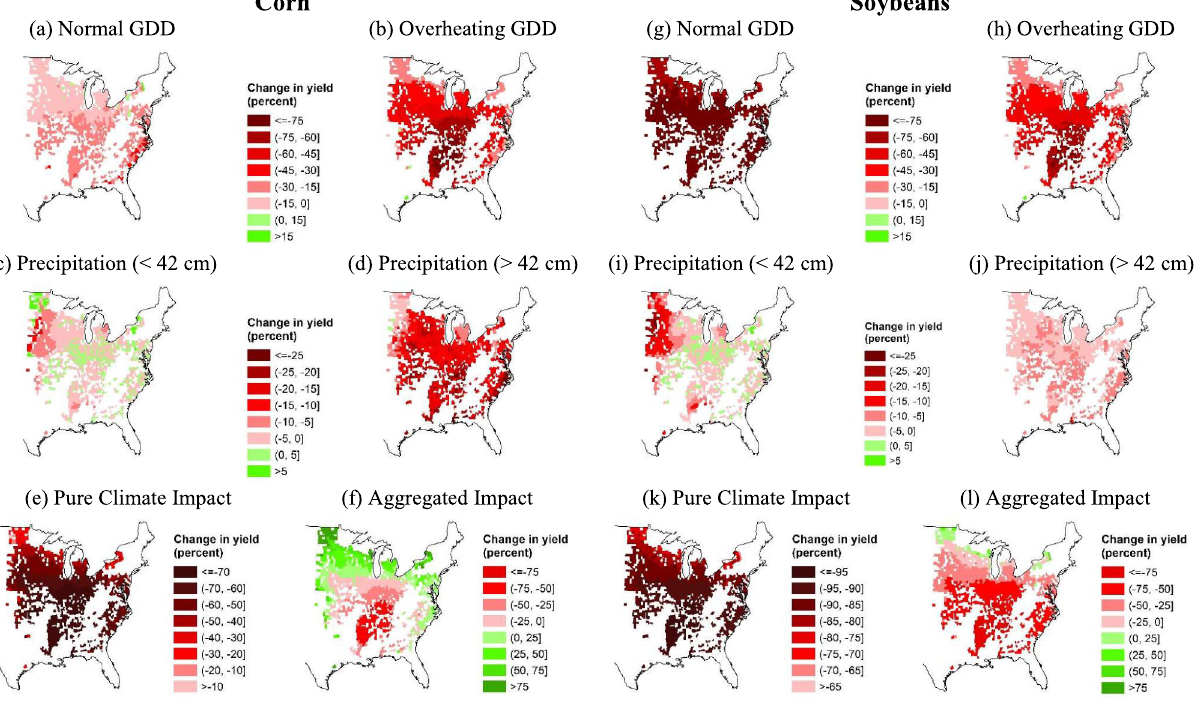
Figure 5. Projected crop yield changes under HadGEM2-ES365 RCP 8.5. Notes : Maps ( a ) to ( e ) (respectively, ( g ) to ( k )) show the projected change in corn (respectively, soybean) yield caused by the changes of different climate variables and overall climate change by 2050 at county level compared to the average yield over 2013–2017. Maps ( f ) and ( l ) show the projected change in corn and soybean yields, respectively, caused by the aggregated impact including the climate change effect and the impact of climate-neutral technological changes. Maps ( a ), ( b ), ( g ), and ( h ) (respectively, ( c ), ( d ), ( i ), and ( j )) share the same legend. All maps are generated using ArcGIS Desktop (v.